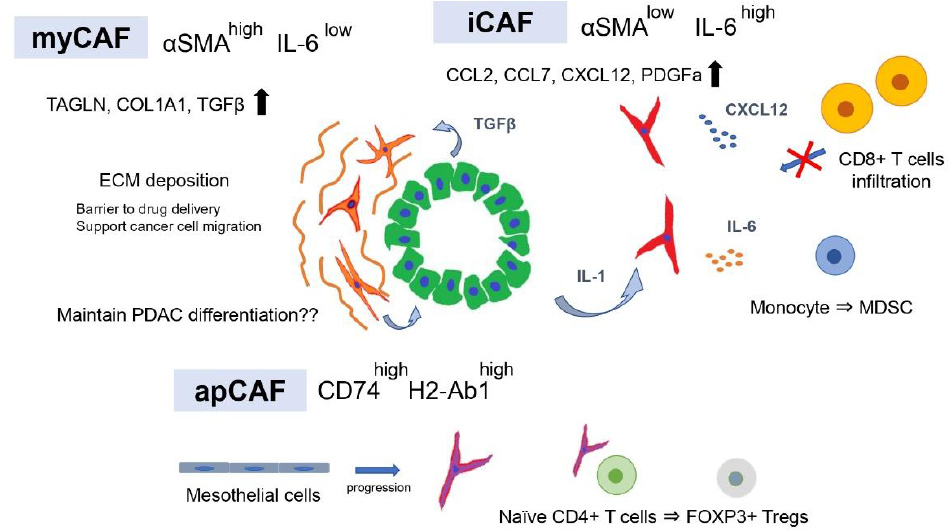
Figure 1. CAF subtypes contribute to the formation of tumor immunosuppressive microenviron-